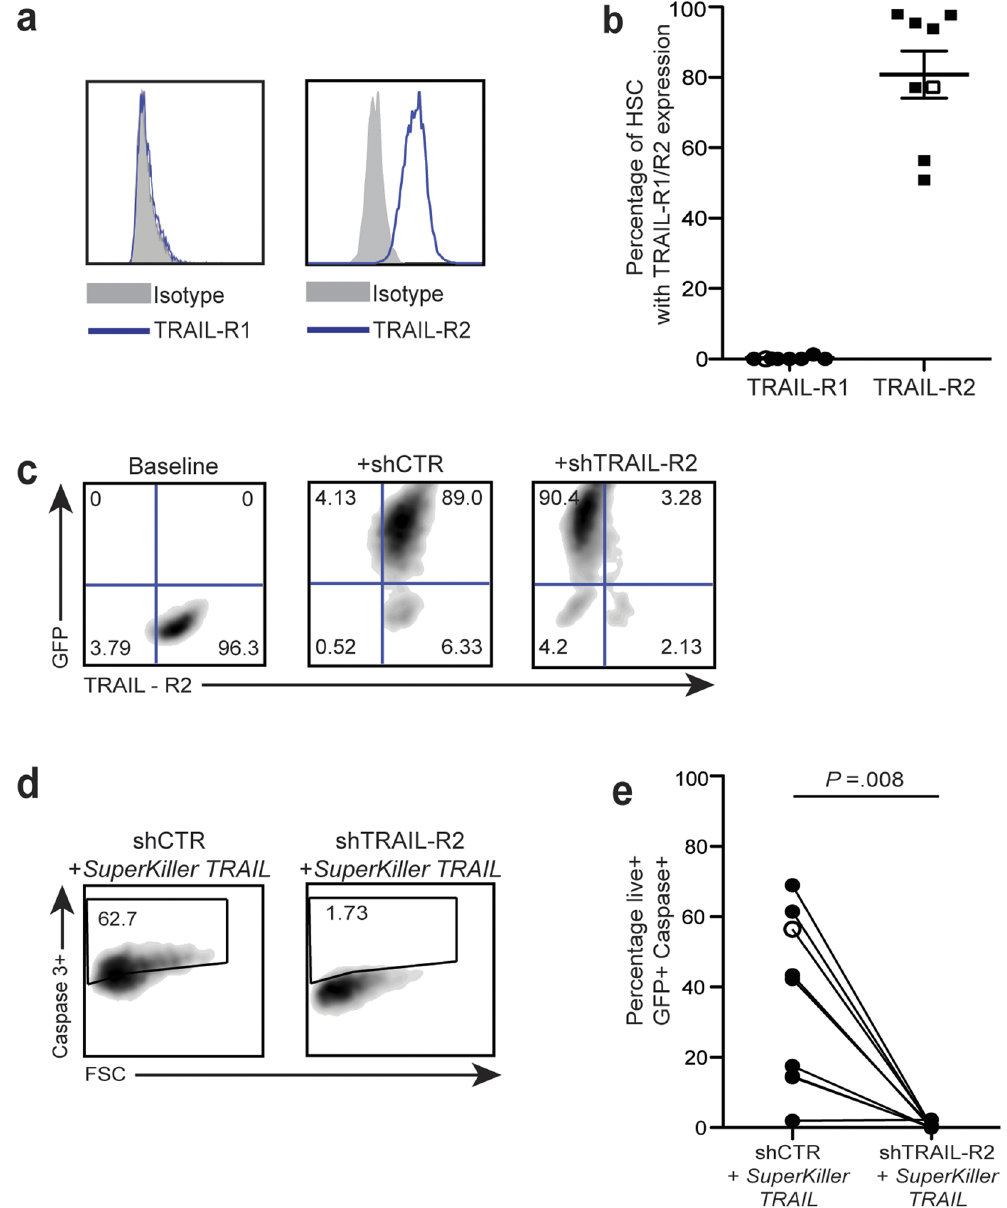
Figure 1. Expression of TRAIL-R2 on primary human HSC has pro-apoptotic function. ( a ) Representative FACS plots of expression level of pro-apoptotic TRAIL-R1 and TRAIL-R2 on hHSC (blue) against matched isotype control (grey). ( b ) Summary of expression levels of TRAIL-R1 and TRAIL-R2 on hHSC from 8 different donors (filled symbols) and LX2 (open symbols). ( c ) Representative FACS plot of levels of TRAIL-R2 at baseline (left), after lentiviral transduction (GFP + ) with shCTR (centre) and shTRAIL-R2 (right). ( d ) hHSC transduced with shCTR and shTRAIL-R2 were treated with SuperKiller TRAIL and the degree of apoptosis of transduced cells was assessed by gating on live GFP + cells that were positive for caspase-3. ( e ) Cumulative graph of apoptosis induction by SuperKiller TRAIL (% caspase3 + GFP + ) hHSC (filled) and LX2 (open circle) post- knockdown of TRAIL-R2 (shTRAIL-R2) compared to control- short-hairpin RNA (shCTR) transduced hHSC. Baseline levels of caspase-3 post-transduction without addition of SuperKiller TRAIL were